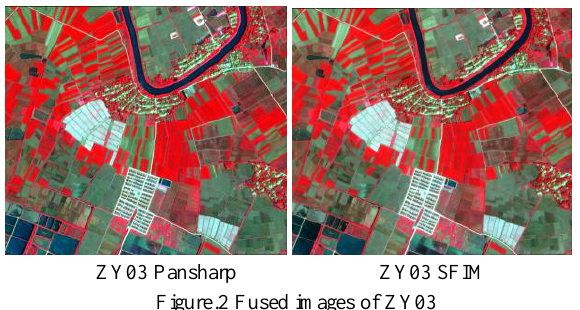
Figure.2 Fused images of ZY03